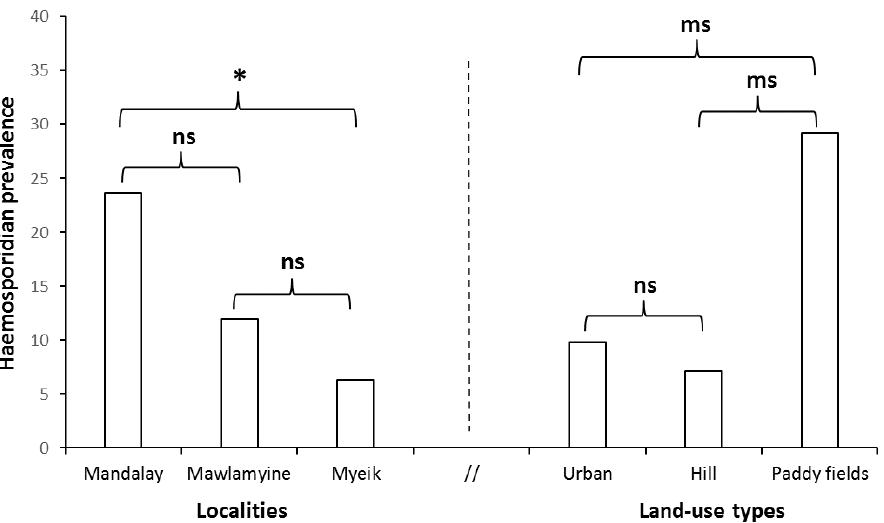
Figure 2. Bar chart showing the avian haemosporidian prevalence between localities and land-use types. Tukey post-hoc tests were utilized to determine significance among localities or land-use types (ns = not significant, ms = marginally significant (0.05 < p < 0.1), * = p < 0.05). Of the 16 birds that tested positive, 75% were infected with Haemoproteus (subgenus Parahaemoproteus ) and 25% were infected with Plasmodium . No individual was infected with proteus and one individual was infected with Plasmodium . In Mawlamyine, one individual was infected with Plasmodium and one individual was infected with Haemoproteus spp.